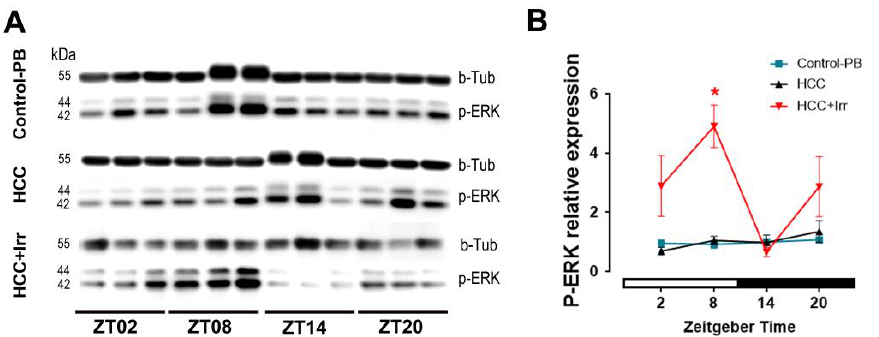
Figure 5. Effect of HCC and irradiation on levels of p-ERK in the hippocampus. ( A ) Immunoreactive bands and ( B ) quantification of p-ERK levels normalized to the housekeeper b-Tubulin in the hip- pocampus of control-PB, HCC-bearing and HCC+Irr mice. *: p < 0.05. White and black bars indicate the day/rest phase and night/activity phase, respectively. n = 12 mice per group, 3 mice at each time point. Control-PB: control mice given phenobarbital (PB) in drinking water. HCC: HCC-bearing mice. HCC+Irr: HCC-bearing irradiated mice. Phosphorylated extracellular signal-regulated kinase (p-ERK). b-Tubulin (b-Tub). Kilo Dalton (kDa). Zeitgeber time (ZT). 4. Discussion Here, we have shown that HCC resulted in an increased expression of pro-inflam- matory cytokines and decreased proliferation and changes in clock gene expression in the hippocampus. Irradiation, in particular when applied in light/rest phase, enhanced all of these effects and also caused the activation of glia, oxidative stress and increased p-ERK protein levels while cFos-IR was decreased. The hippocampal-dependent cognitive functions such as memory formation and ex- tinction are largely time-of-day-dependent and are influenced by the circadian system [27]. In the hippocampus of untreated mice, the expression of clock genes except Per2 and Rev-Erba showed a peak during the early light/inactive phase in agreement with previ- ously reported findings [28, 29]. Interestingly, expression of pro-inflammatory cytokines including IL-1a , IL-1b and TNF- α showed the same peak, suggesting an interaction of the molecular clockwork and the innate immune system in the hippocampus. There is increas- ing evidence of an interaction between the molecular clockwork and neuroinflammation [30, 31]. In addition, studies using knock-out mice showed an interaction of Bmal1 [32] and Rev-Erba [33] with the innate immune system of the brain. Importantly, in mice chronically